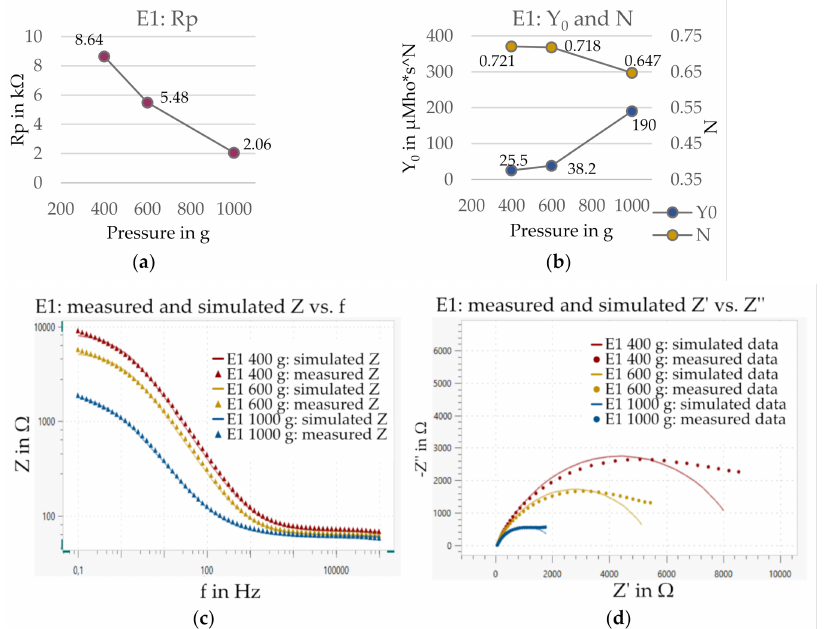
Figure 15. ( a , b ) Circuit elements Rp and CPE parameters Y 0 and N for electrode E1 on agar dummy with pressure applied to the system. Estimated errors are indicated by error bars, which are not visible because they are too small. ( c , d ) Comparison of measured data and simulated EC curves over the entire frequency range for electrode E1 (circle, low yarn density, smooth surface). Goodness of fit χ 2 (400 g) = 0.23; χ 2 (600 g) = 0.21; χ 2 (1000 g) =